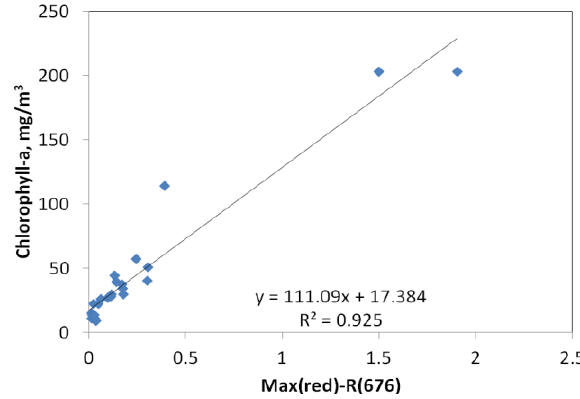
Figure 3. Correlation between the height of the reflectance peak near 700 nm and concentration of